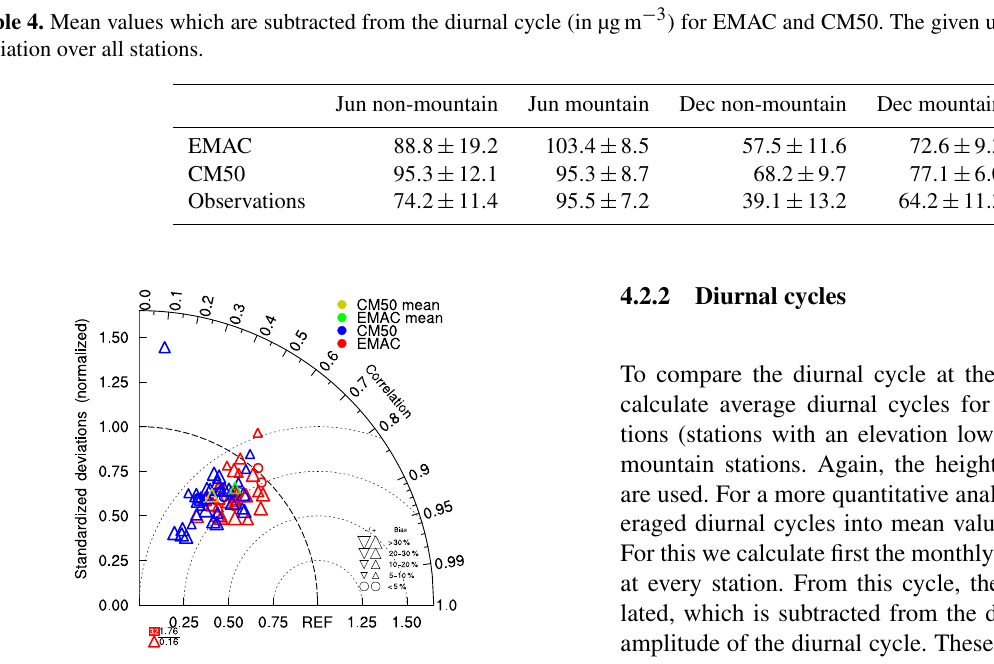
Figure 9. The same as Fig. 8 but for the whole year 2008.